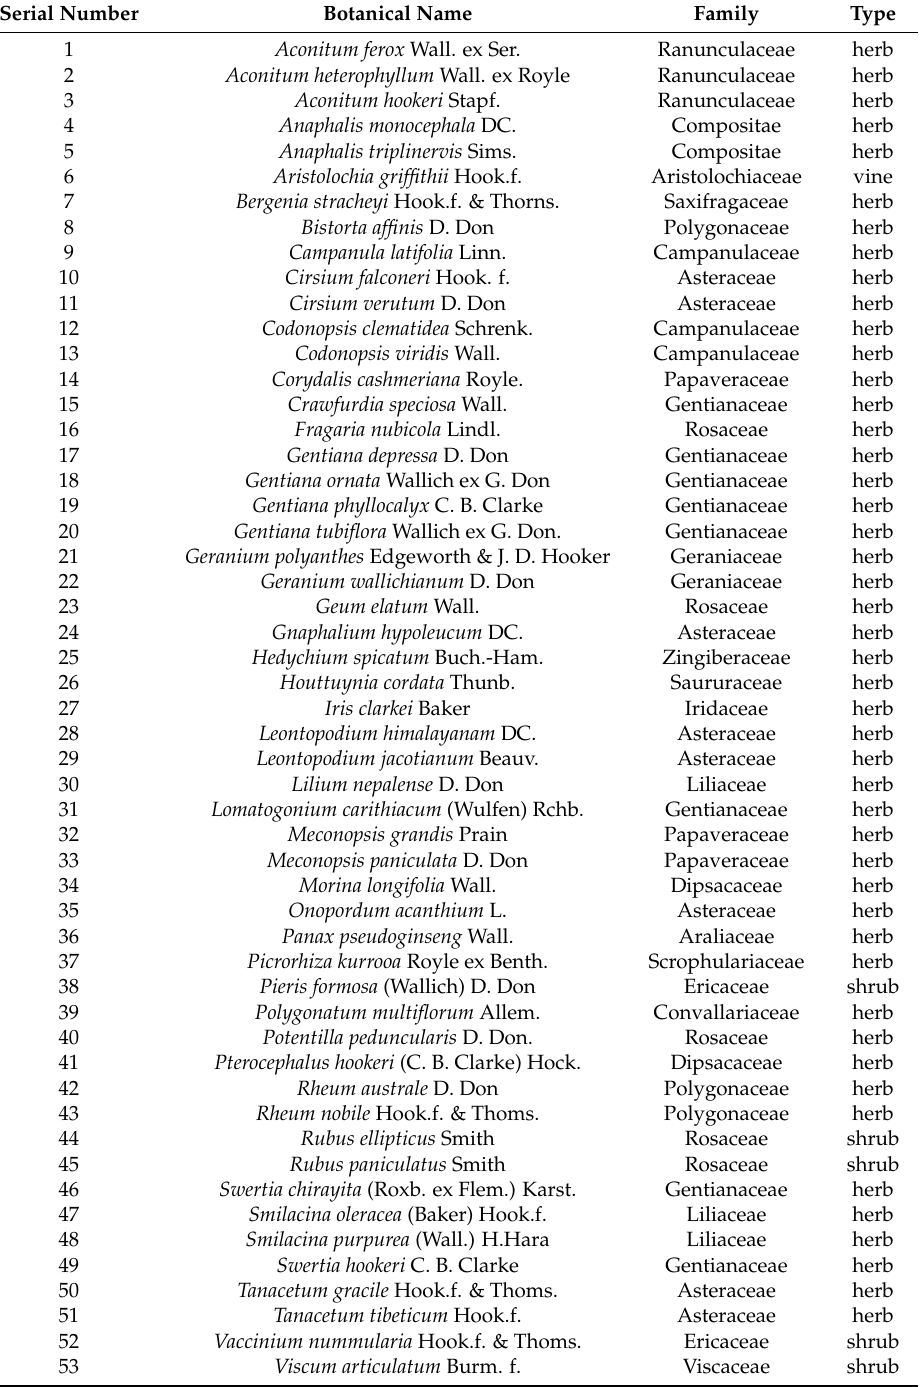
Table 2. List of recorded plants used in